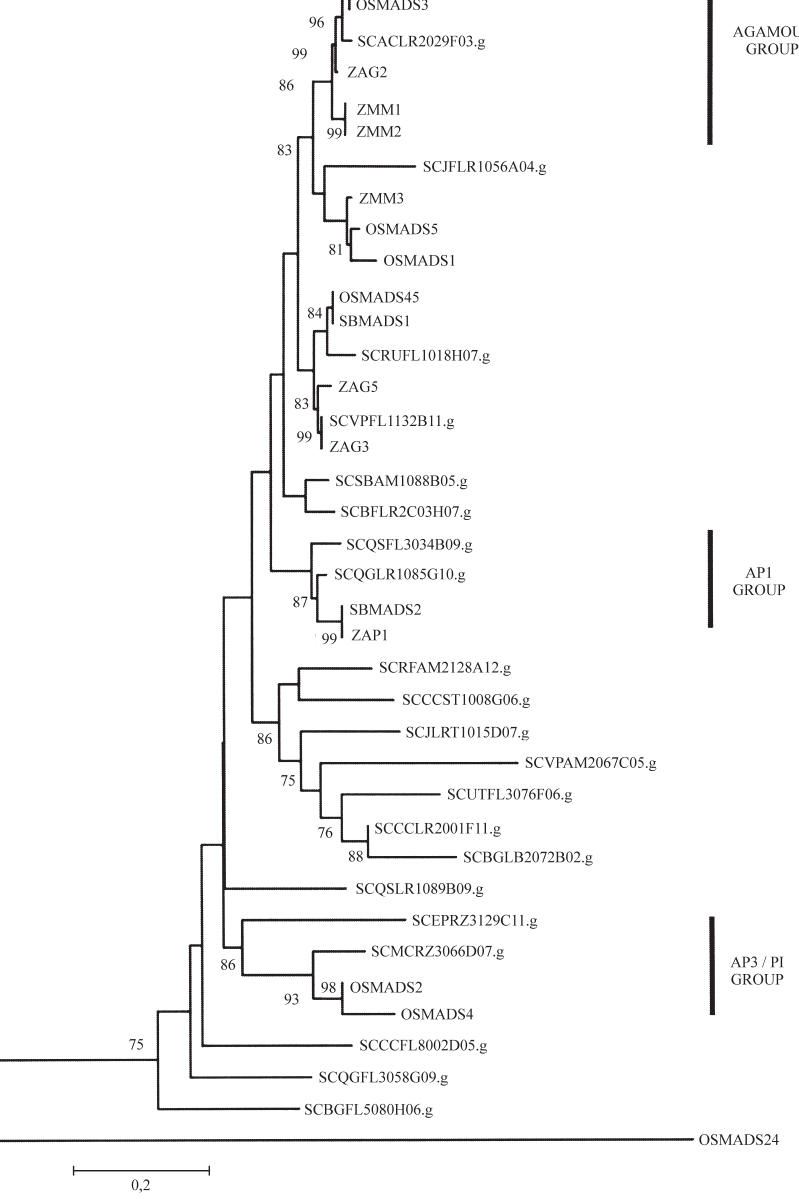
Figure2 - PhylogeneticrelationshipsamonggrassMADS-boxtranscriptionfactors.Themostparsimoniousconsensustreehaditsbranchesscaledtothe corresponding genetic distances. Only Bootstrap values (1000 replicates) higher than 75% are shown. For reference numbers and references to the gene sequences used, see